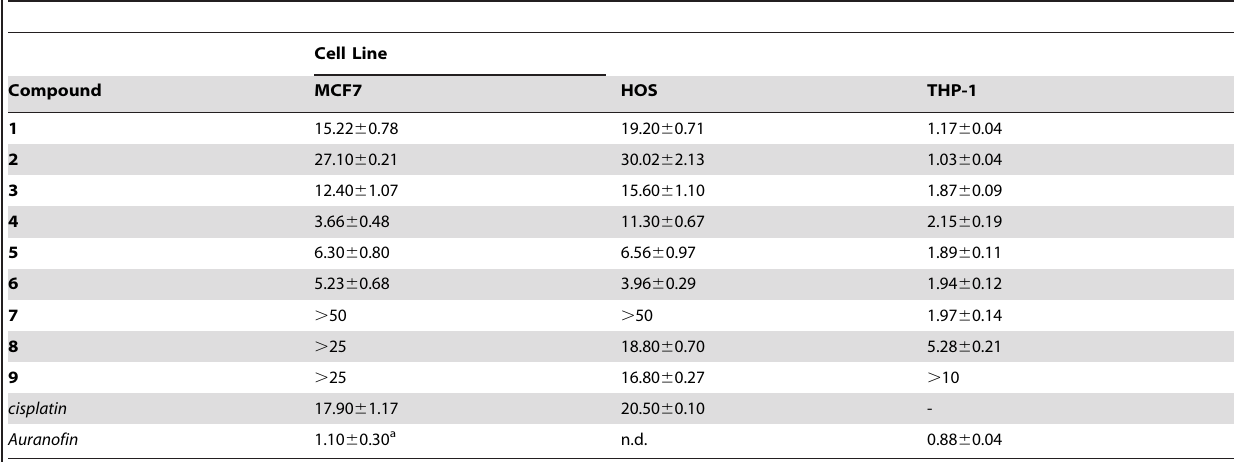
Table 2. In vitro cytotoxicity of complexes 1–9 and cisplatin against MCF7 and HOS cancer cell lines.